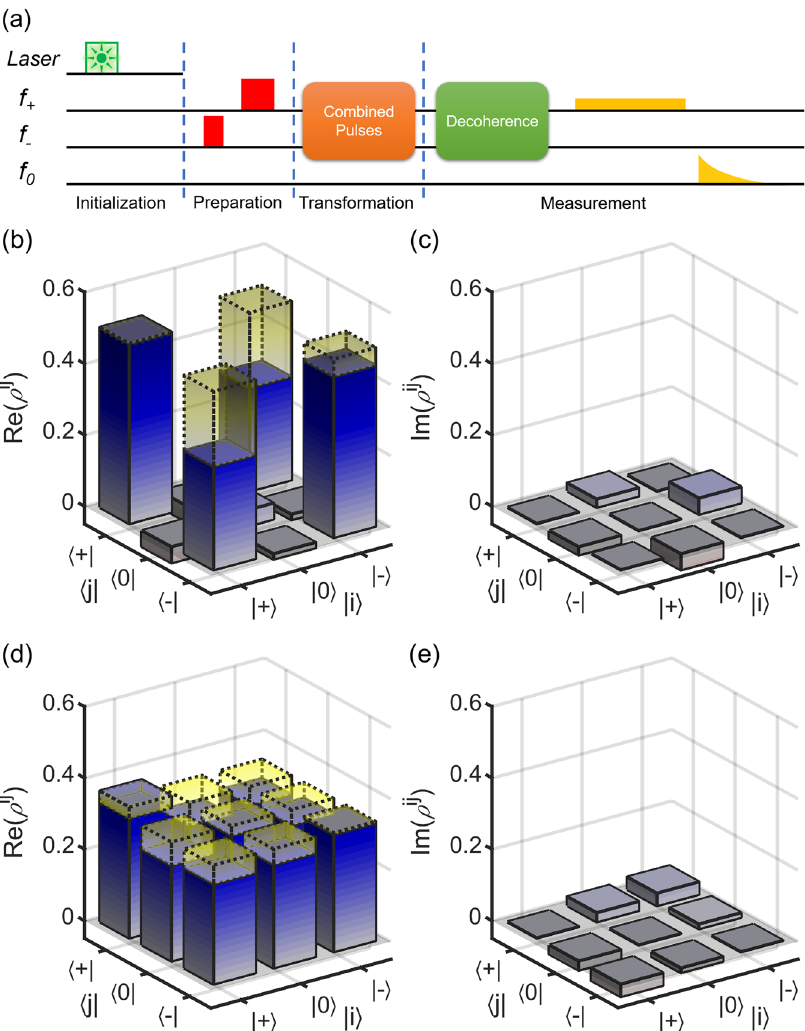
j i and ψ j i . b – e Real 1 2